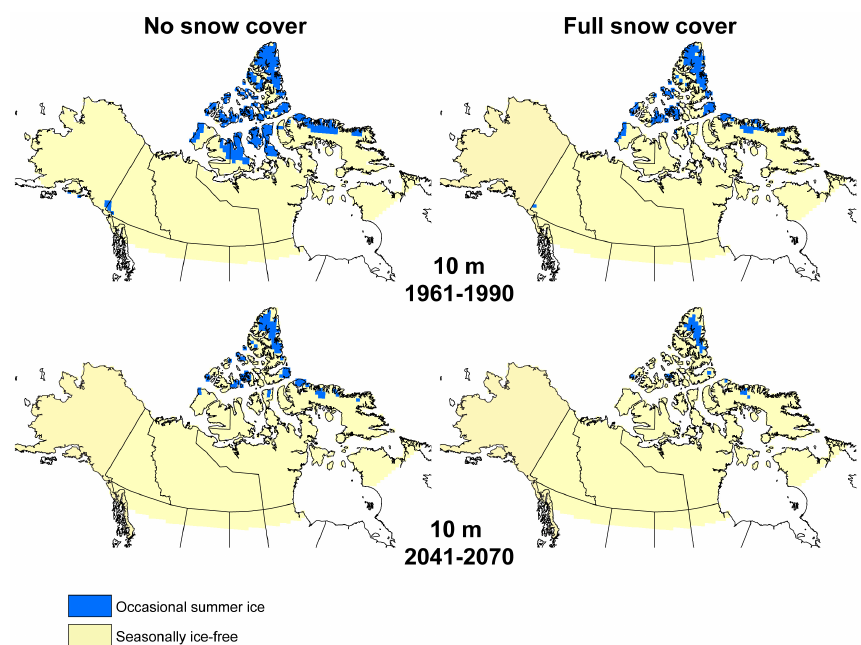
Fig. 13. Area of occasional summer ice (including perennial ice cover) and the change from 1961–1990 to 2041–2070. Scenario 1, 10m lakes